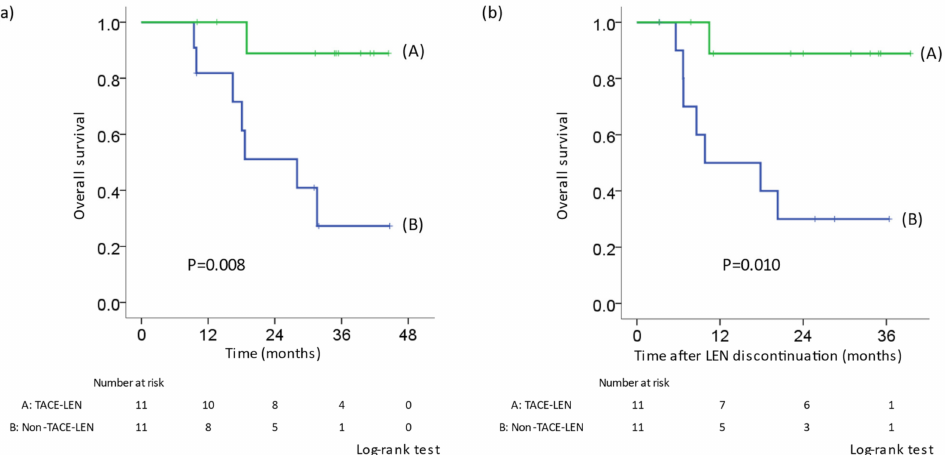
Figure 3. Kaplan–Meier curve for OS after adjustment by propensity score matching in patients who received LEN in the first line. TACE-LEN: LEN was re-administered after TACE. ( a ) OS from the initiation of LEN. ( b ) OS from the first discontinuation. The OS in the TACE-LEN group was significantly prolonged in comparison to patients who received other therapies. LEN, lenvatinib; TACE, transcatheter arterial chemoembolization; OS, overall